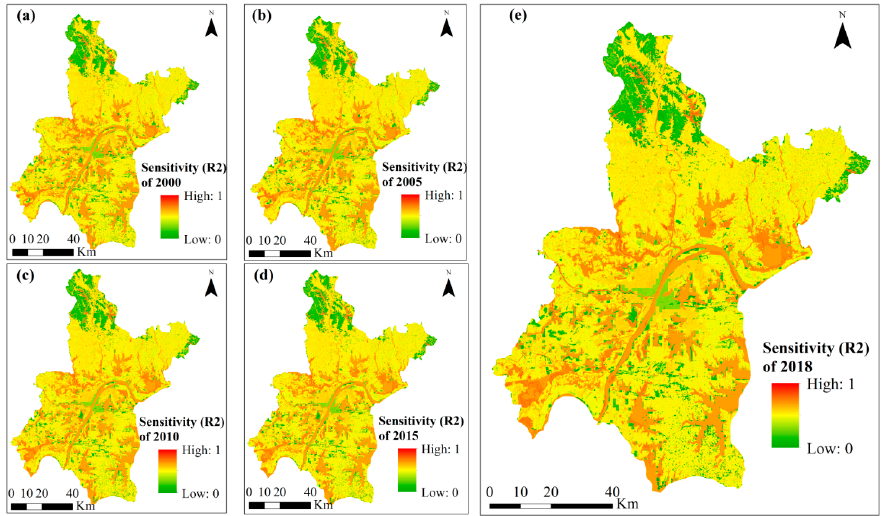
Figure 6. Spatiotemporal patterns of flood sensitivity in Wuhan (( a ) 2000, ( b ) 2005, ( c ) 2010, ( d ) 2015, ( e ) 2018).